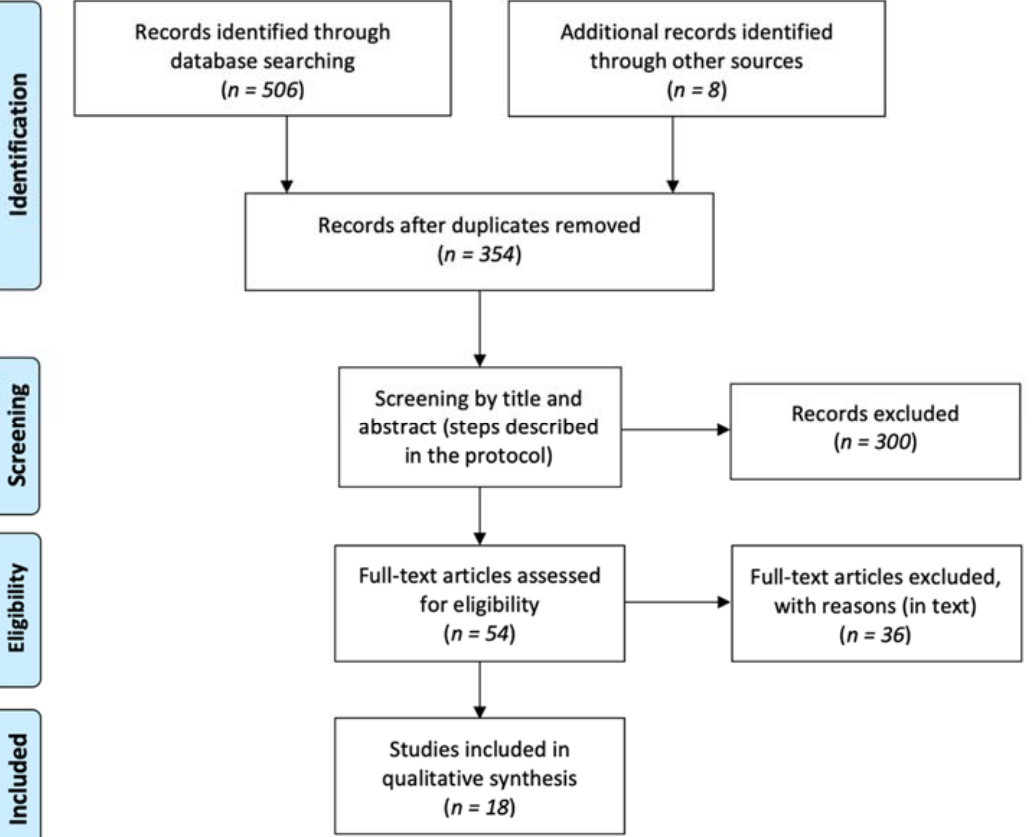
Figure 1. PRISMA flow diagram of search and selection Figure 1 . PRISMA flow diagram of search and selection strategy.